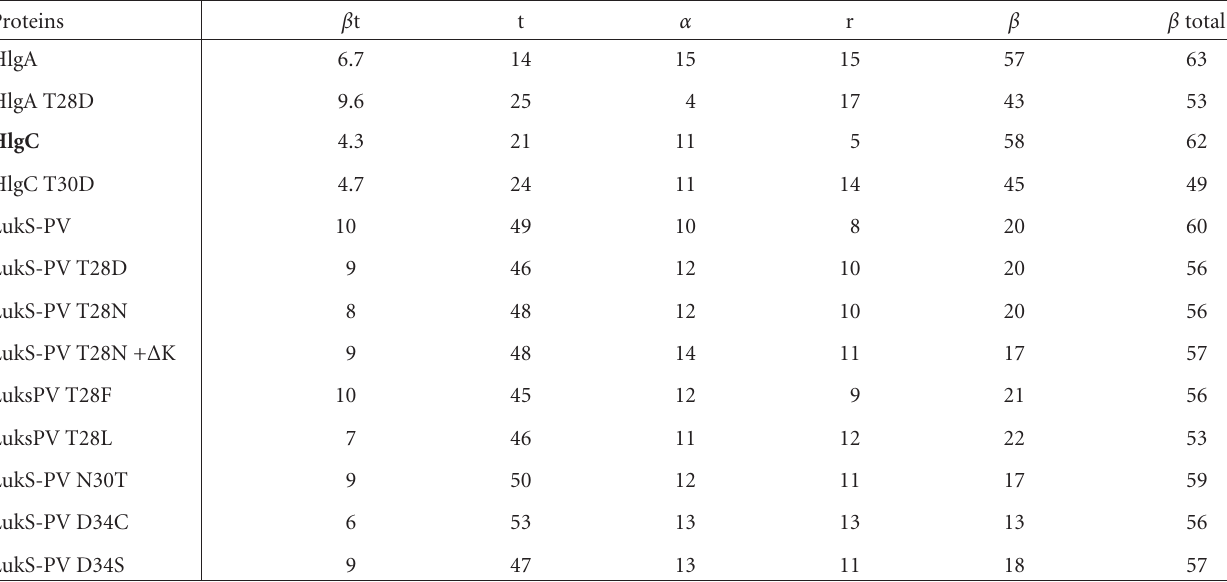
Table 1: Determination of the secondary structure of the leucotoxins by ATR-FTIR. The Lorentzian average corresponds to particular secondary structure (Byler and Susi). β 1 = antiparallel β -sheet, β 2 = parallel and antiparallel β -sheet, α = α -helice, t = β -turn and r =